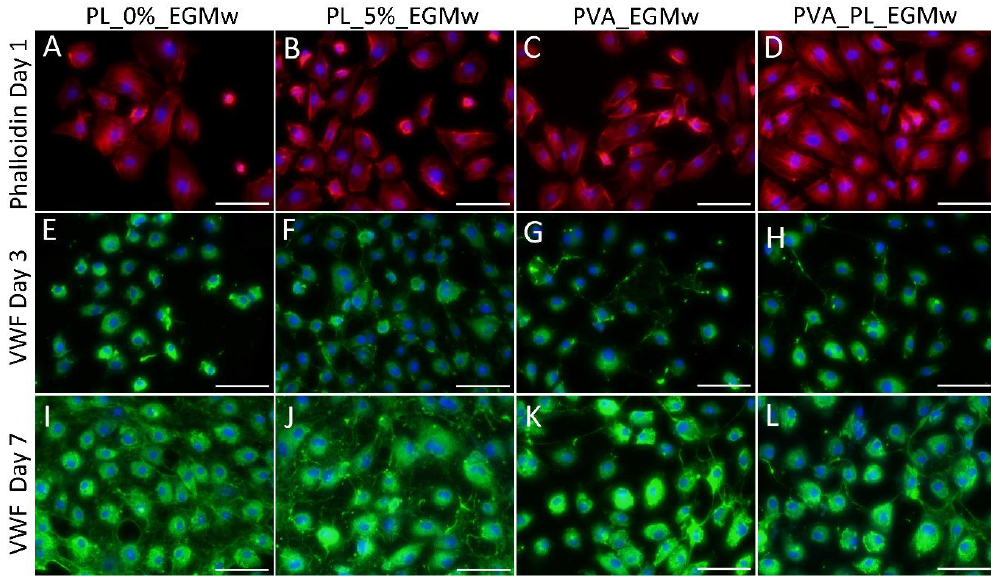
Figure 8. Staining of the HSVEC cells with phalloidin–tetramethylrhodamin (phalloidin-TRITC) for F-actin on day 1 following seeding ( A – D ) and the immunofluorescence staining of the von Willebrand factor (VWF) on day 3 ( E – H ) and on day 7 ( I – L ). The cells were seeded on glass in the EGMw medium without PL ( A , E , I ), with 5% of PL ( B , F , J ), with PVA ( C , G , K ) and with PVA–PL ( D , H , L ). Olympus epifluorescence microscope IX71, D71 digital camera, obj. × 20, scale bar = 100 µm. The positive effect of platelet lysate on HSVEC viability might be explained by the presence of biomolecules that are important for endothelialization such as VEGF, FGF-2,